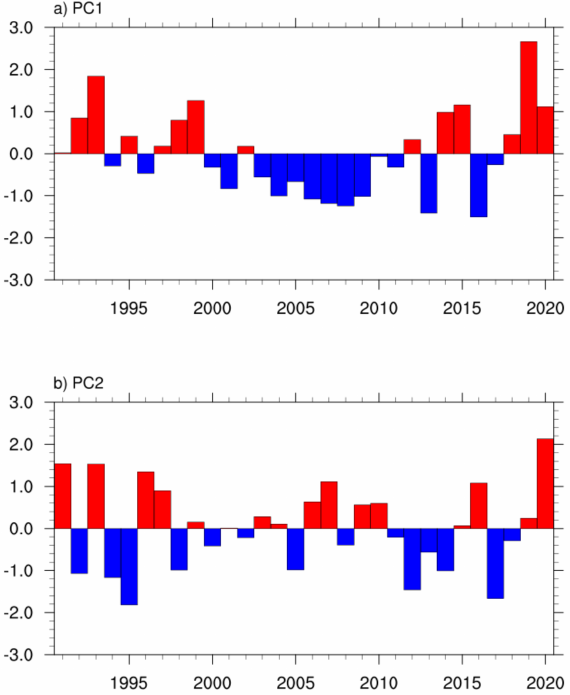
Figure 3. The corresponding time series for the first ( a ) and second ( b ) CEOF